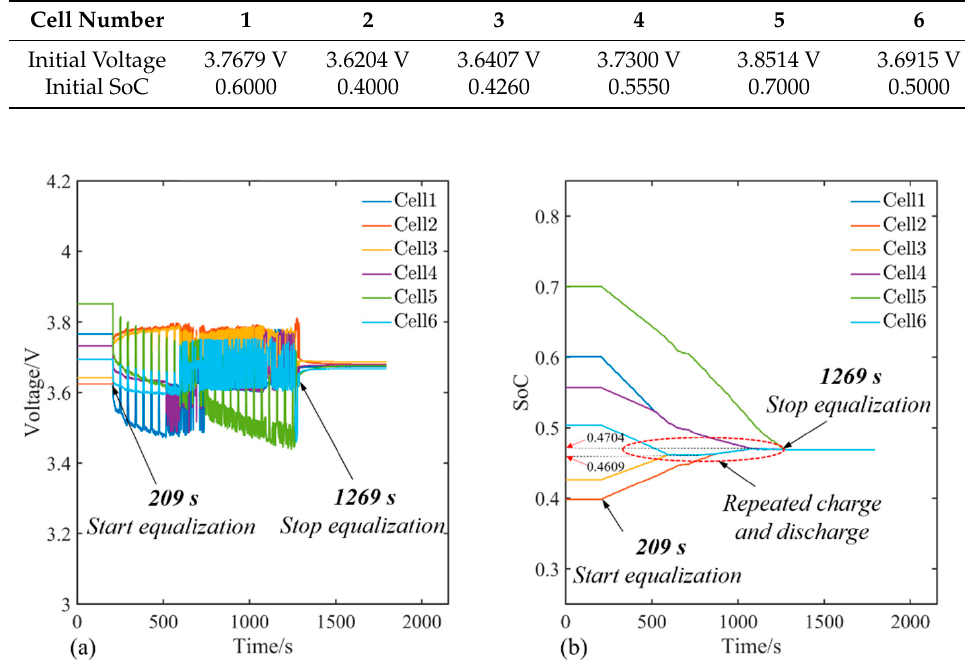
Figure 8. Equalization experiment based on FDC: ( a ) Voltage; ( b ) SoC.